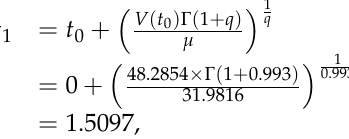
Figure 3. Identification for unknown parameters, ( ) i t α .